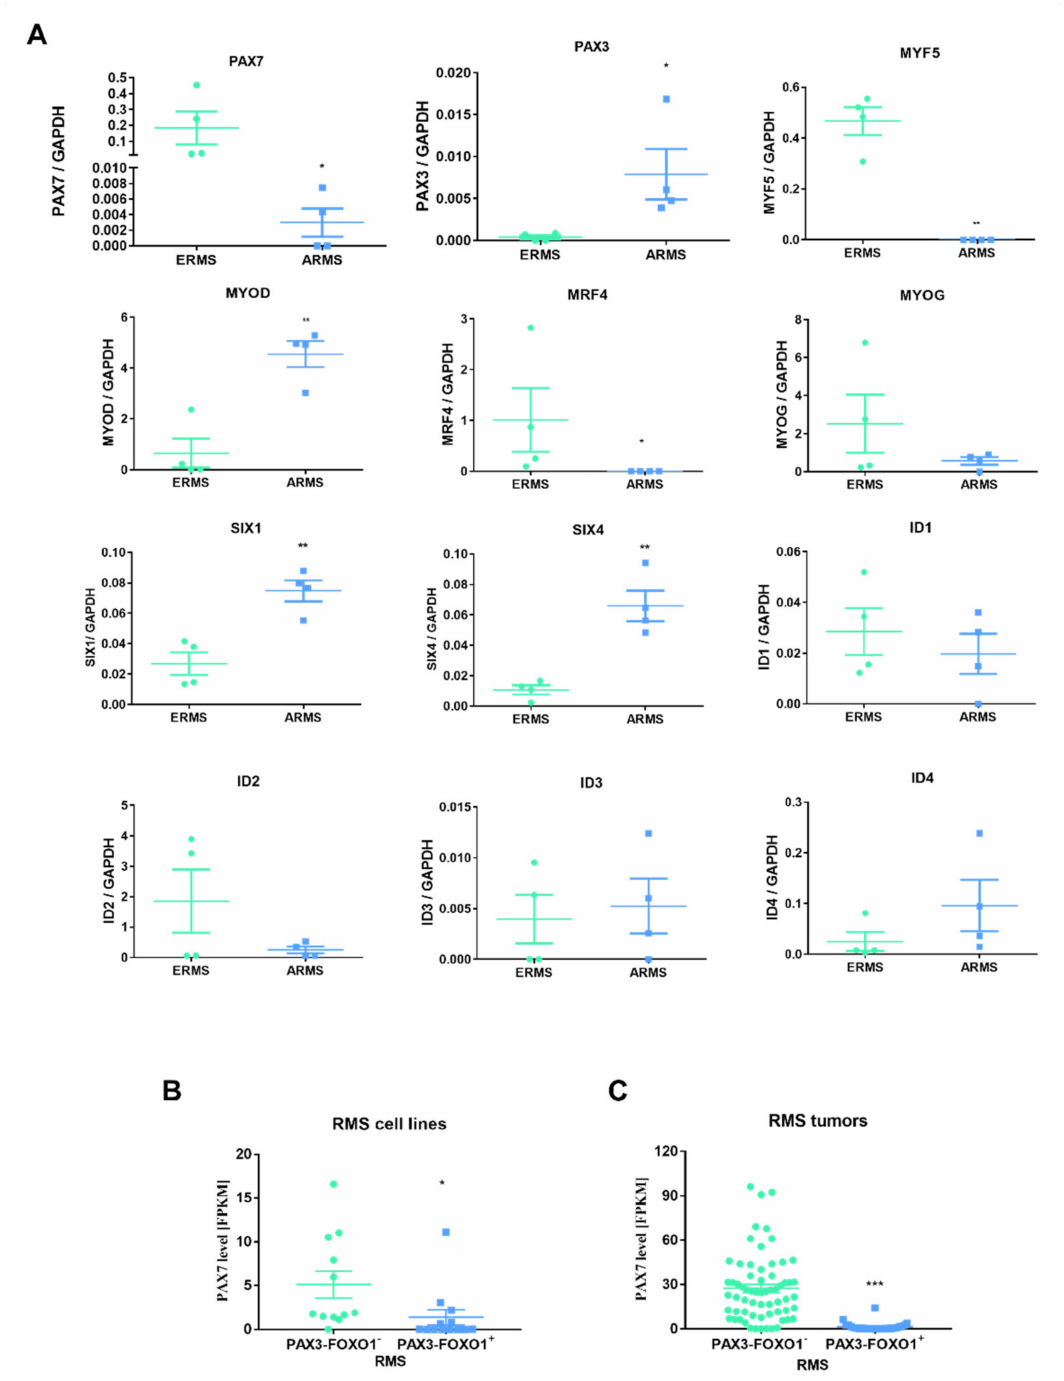
Figure 9. Transcription factors regulating myogenic differentiation were differentially expressed in ERMS and ARMS tumors in patients. ( A ) mRNA expression levels of different genes were evaluated with qPCR in four ERMS and four ARMS tumor samples from patients. Data were calculated with 2 − ∆ Ct method using GAPDH as a constitutive gene, n = 4. ( B ) PAX7 level in FPKM in 25 cell RMS lines positive and negative for PAX3-FOXO1 fusion extracted from the literature table results published by Gryder et al. 2017 [32] were reanalyzed and presented as dot plots. PAX7 level was diminished in ARMS cells positive for PAX3-FOXO1 fusion. ( C ) PAX7 level in FPKM in 90 RMS tumor samples positive and negative for PAX3-FOXO1 fusion extracted from the literature table results published by Gryder et al. 2017 [32] were reanalyzed and presented as dot plots. PAX7 level was diminished in RMS tumors positive for PAX3-FOXO1 fusion. The data on graphs is shown as dot plots with means ± SEM * p < 0.05, ** p < 0.01, *** p <